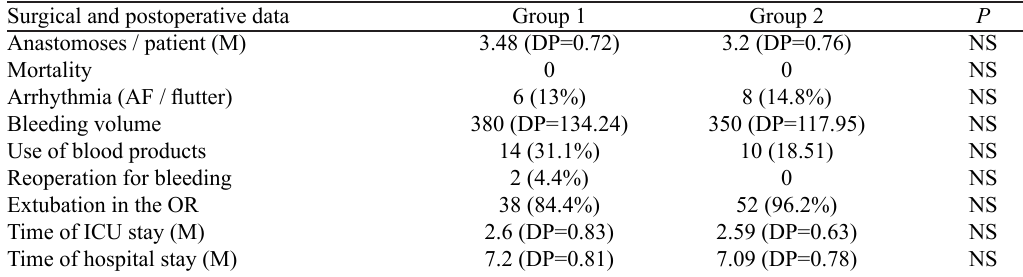
Table 2. Surgical and postoperative data.